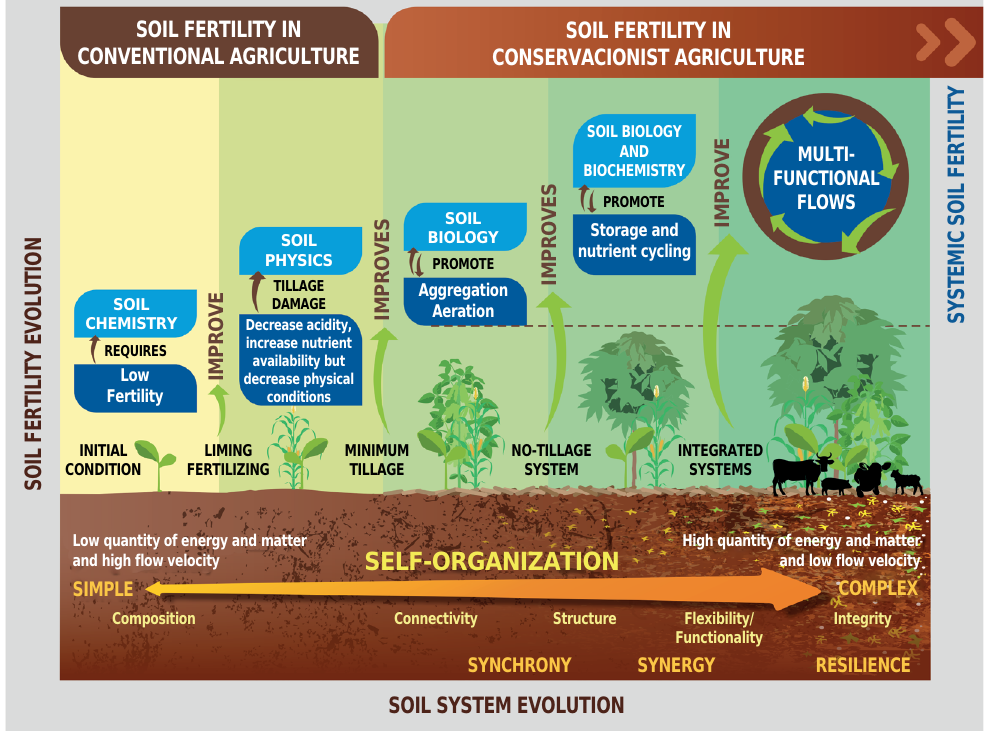
Figure 1. Systemic Soil Fertility as product of the self-organization of the system resulting from management. As management practices evolve towards increasing the magnitude and reducing the velocity of the flow of energy and matter, which results in longer residence time of organic compounds in the soil, the system changes from a simple structural condition to a complex one, in a self-organizing process. Along this path, soil properties (dark blue boxes) change in number and function, requiring that other Soil Science disciplines (light blue boxes) be considered to characterize Soil Fertility. The process of self-organization over time is identified by the evolutionary parameters of composition, connectivity, structure, flexibility-functionality, and integrity (Vieira, 2000) and the emergence of synchrony, synergy and resilience properties, showing the integration of components and their joint functioning until multifunctional flows are achieved, which provide both nutrient availability and stocks, fluxes of gases, water and solutes, and biological diversity and activity - which constitutes Systemic Soil